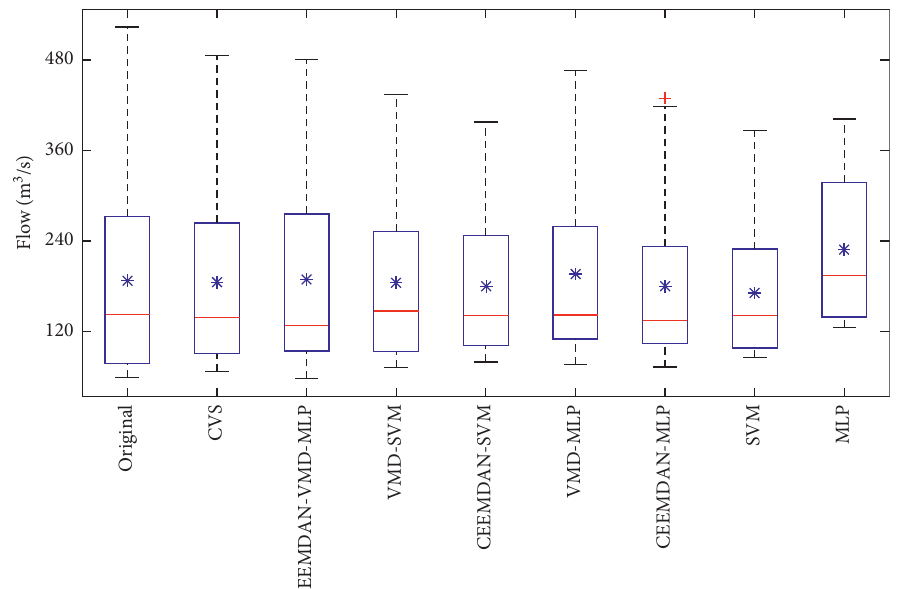
Figure 13: Boxplot of runoff during the testing period for hybrid models and the benchmark model. The red line marks the median in addition to the mean (blue star).